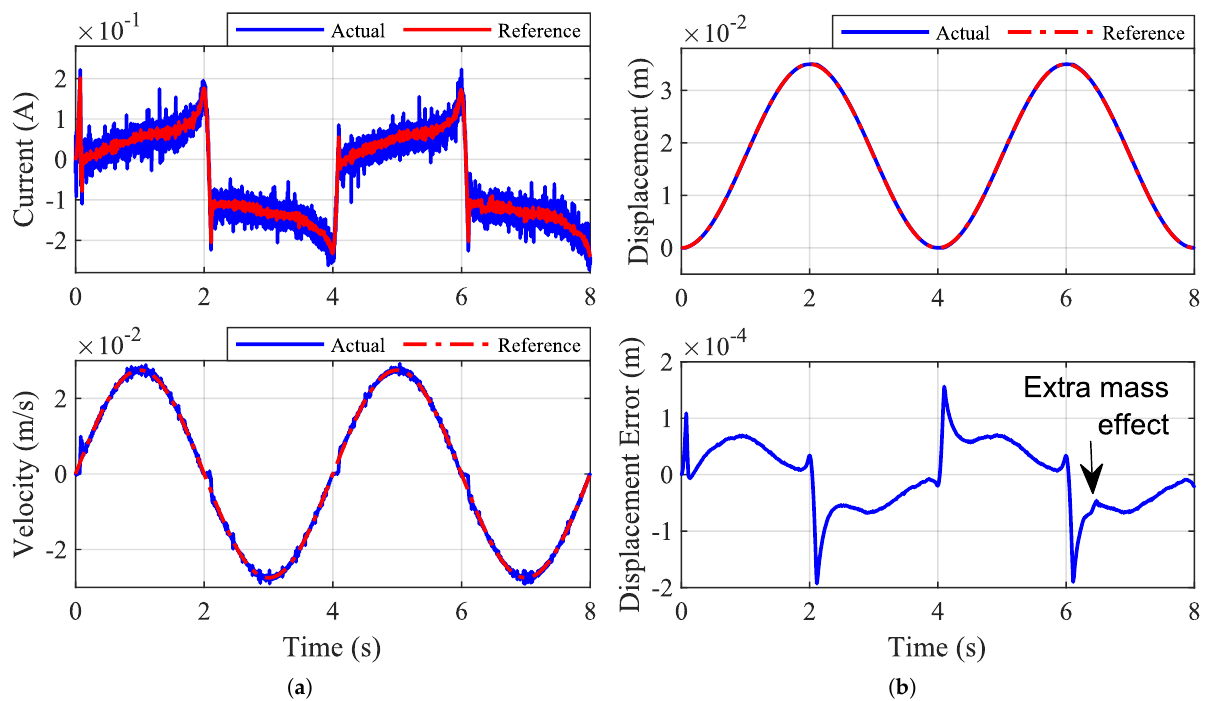
Figure 18. Experimental waveforms for sinusoidal position-tracking using the ADRC method for two consecutive periods at 0.25 Hz showing the effect of extra mass when introduced in the second period. ( a ) Current and velocity; ( b ) displacement and displacement error.